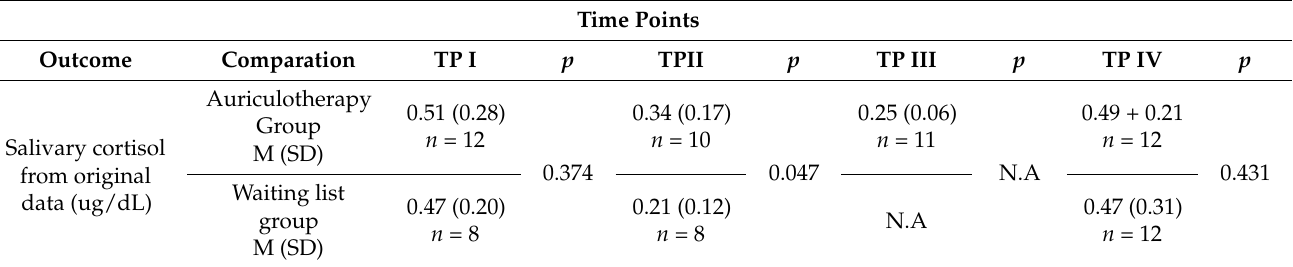
Table 3. Outcome of the investigation data by independent samples t -test given as mean and standard deviations of anxiety levels measured by salivary cortisol.